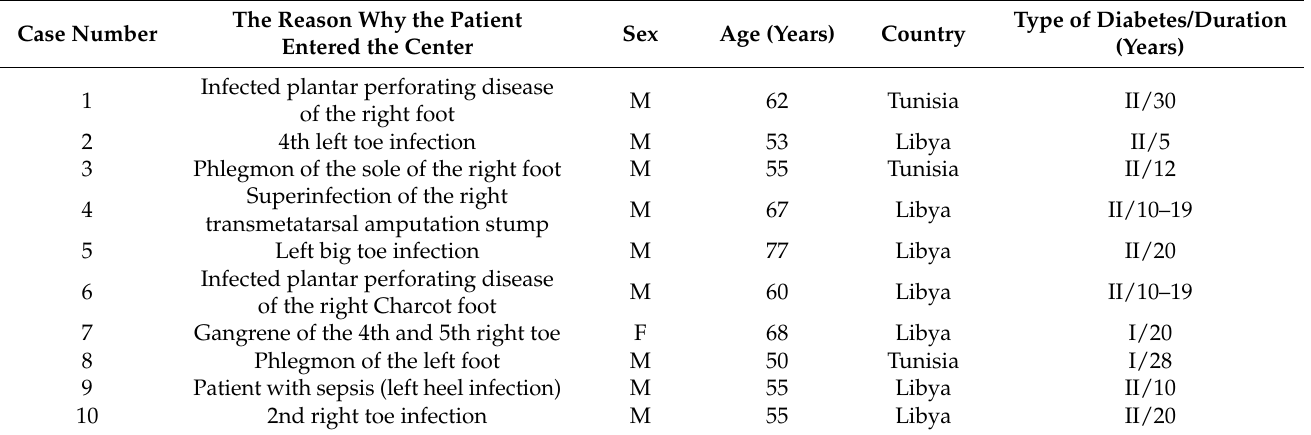
Table 1. Characteristics of 64 patients included in this